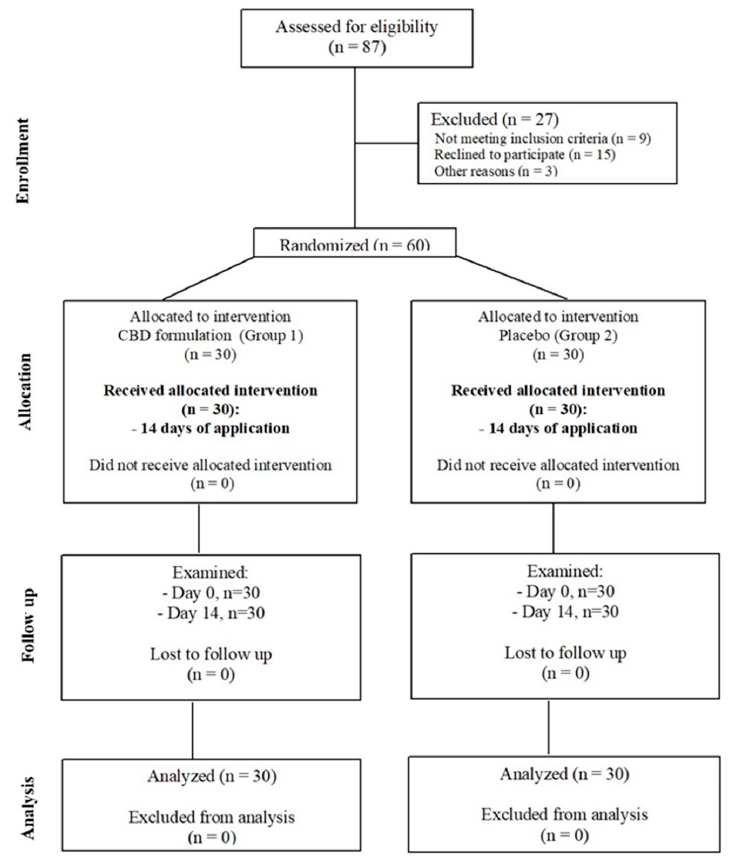
Figure 2. Flow chart of the two arms consolidated standards of reporting trials (CONSORT)-randomized study.